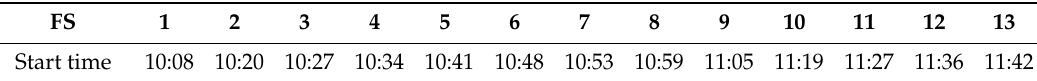
Table 1. Flight stripe (FS) acquisition time of day